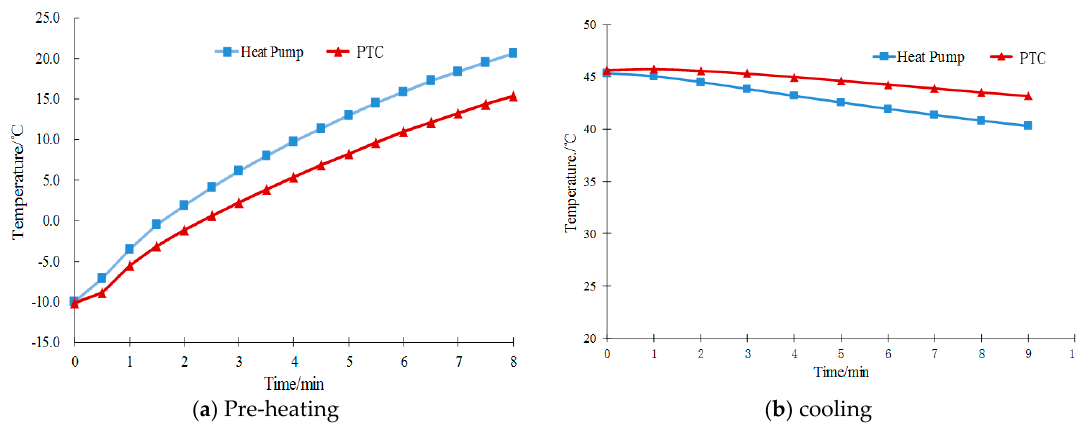
Figure 13. The data of preheating and cooling.